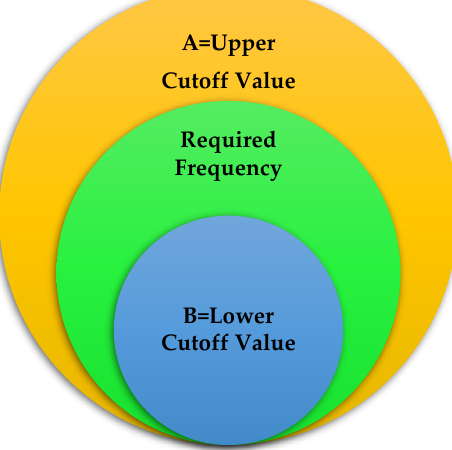
Figure 3. Frequencies Ranges of Chosen Data.